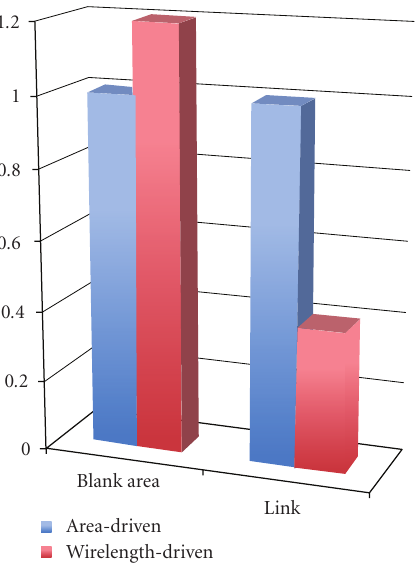
Figure 4: Comparison of the area and wirelength metrics among the area-driven and wirelength-driven approaches (normalized w.r.t. area-driven approach).